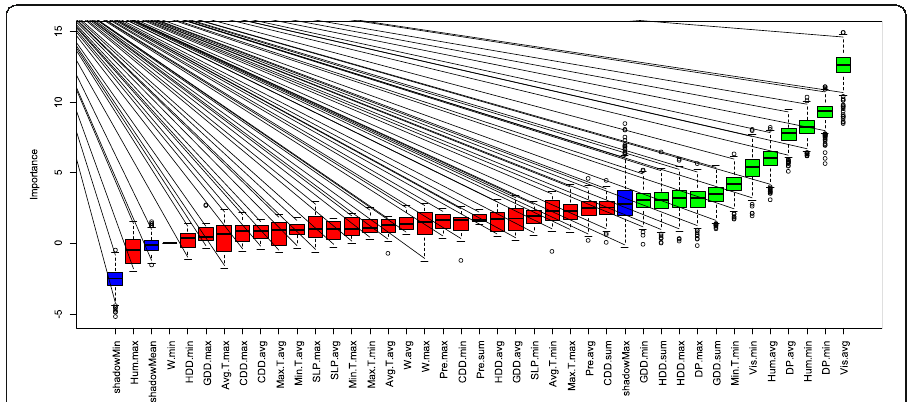
Fig. 1 The feature importance ranking of the Boruta